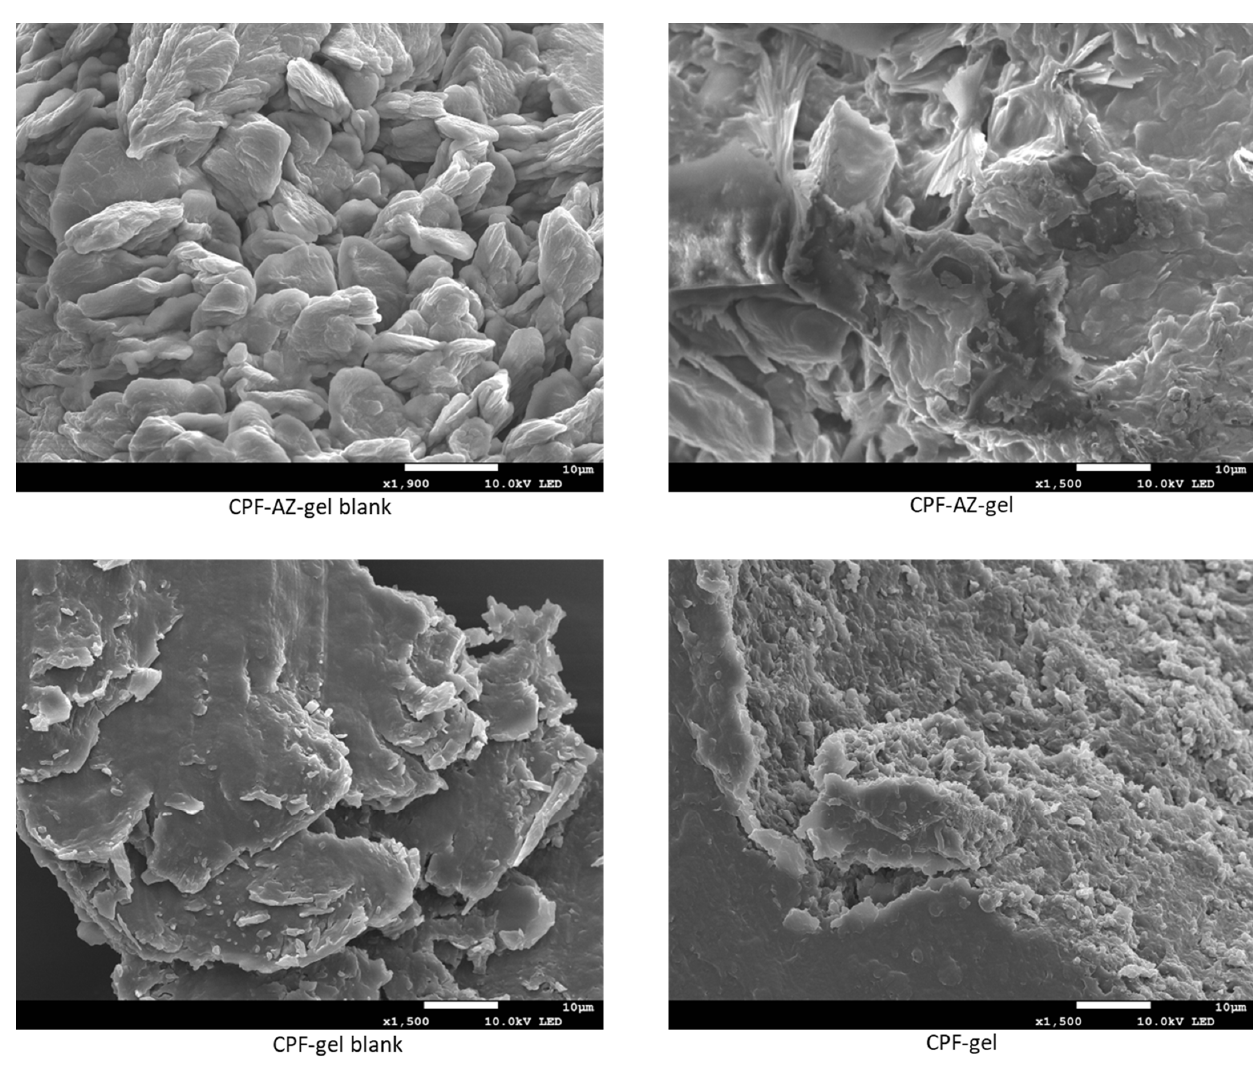
Figure 7. SEM images of the hydrogels: left panels show the blank hydrogels with or without permeation enhancers, and the right panels display the loaded hydrogels.